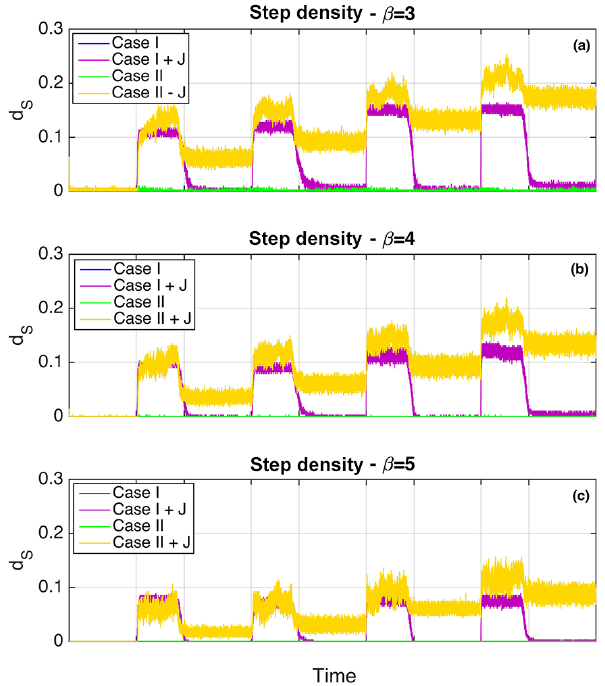
Figure 14. Unsteady simulations with four consecutive floods. Time series of step density with (a) β = 3, (b) β = 4, and (c) β =